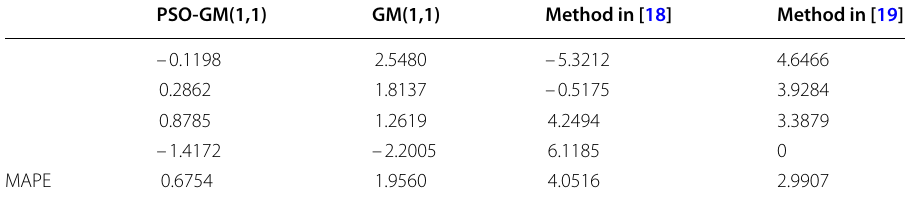
Table 3 Percentage forecast errors associated with the various models, for energy data for a laptop